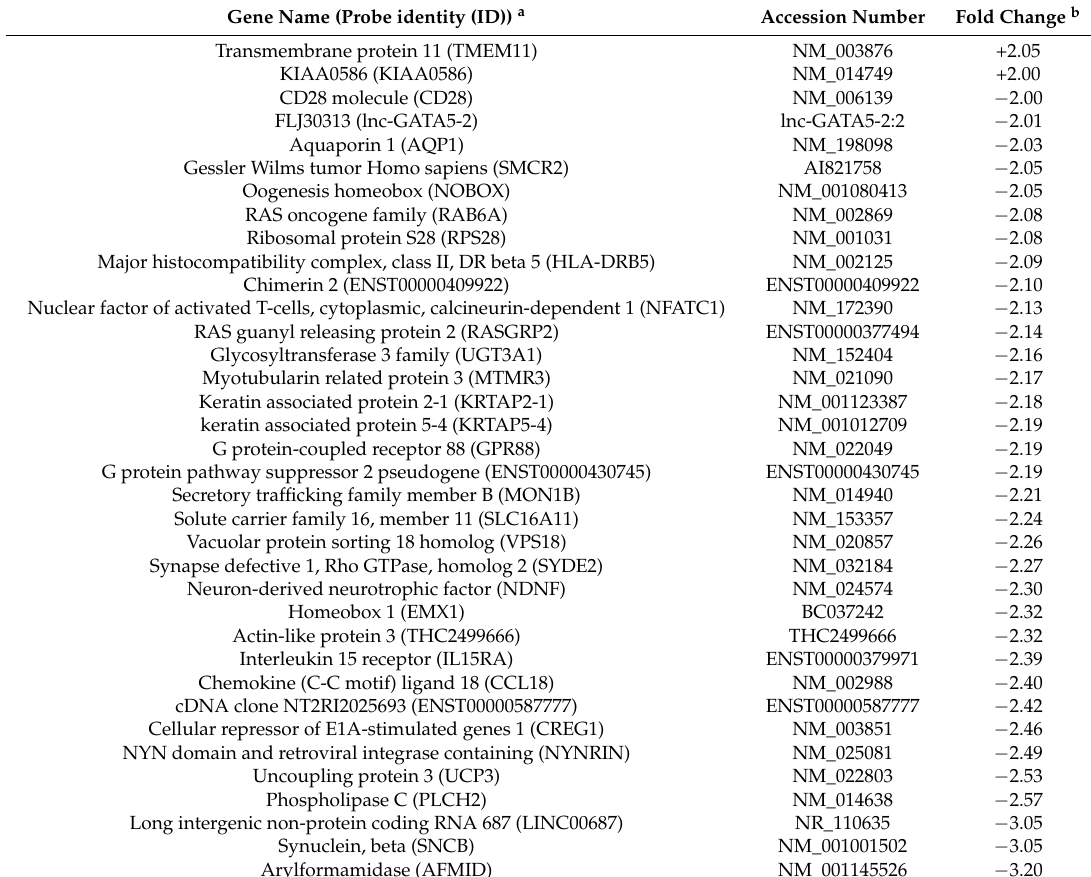
Table 1. List of genes differentially regulated in human monocyte-derived dendritic cells (moDCs) infected with modified vaccinia virus Ankara (MVA)-hepatitis C virus (HCV) ∆ C6L in comparison with MVA-HCV. a The gene name and the probe ID are indicated. b Differentially expressed genes were evaluated by the non-parametric algorithm “Rank Products” available as “RankProd” package at Bioconductor, and the genes were filtered using a p value Limma < 0.05 and a fold change of ≥ 2 or ≤−